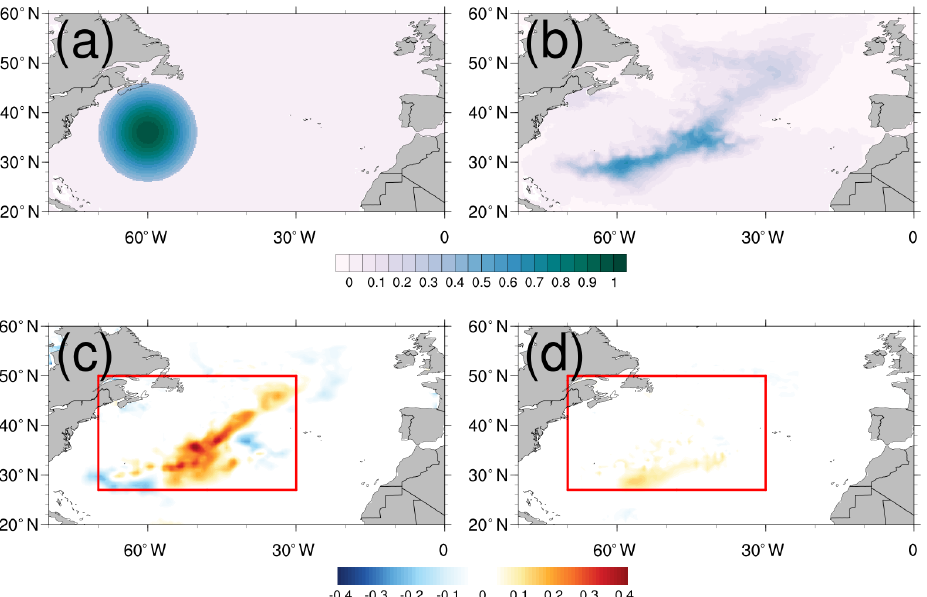
Figure 6. Passive tracer initial condition for PATCH experiment (a) , tracer concentration at 16m depth after 1 year for the HR configura- tion (b) and difference with LR (c) and HRCRS configurations (d) , respectively.